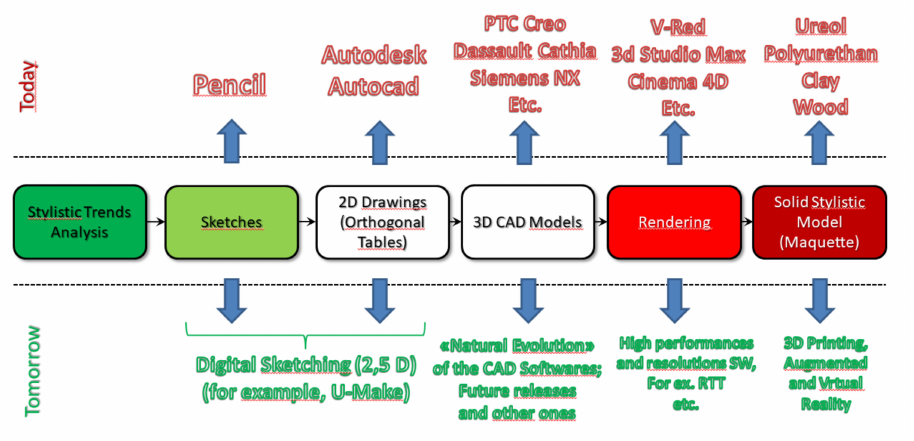
Figure 39. Future Developments